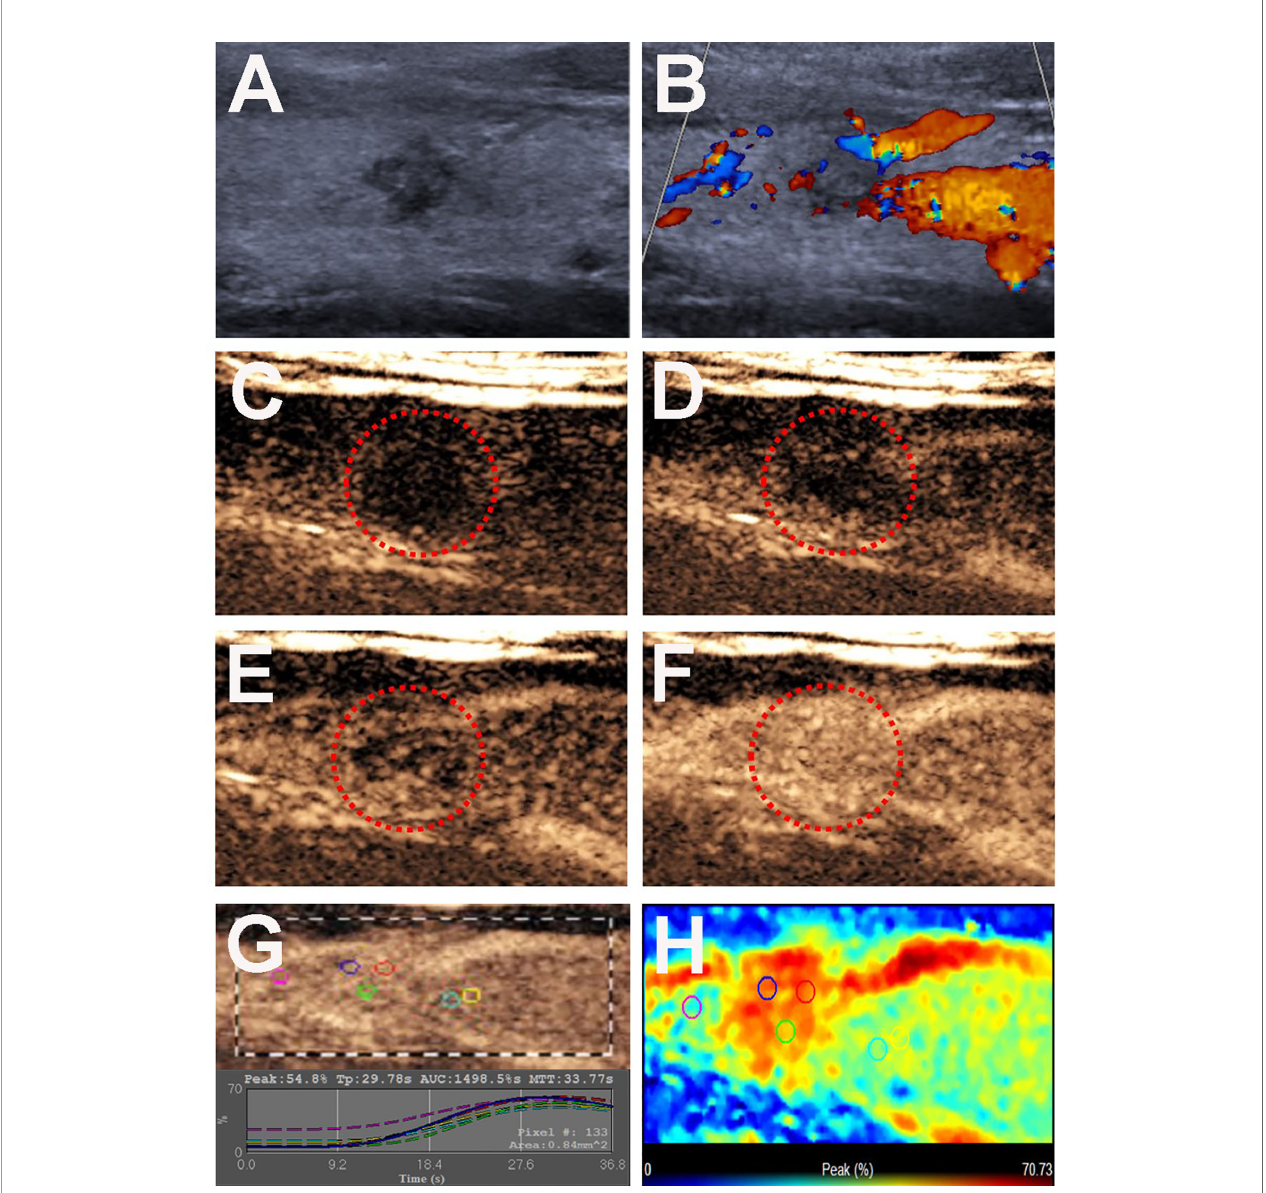
FIGURE 4 | Conventional US and CEUS images of a 26-y-old male PTC patient with Hashimoto ’ s thyroiditis of the right thyroid lobe without CLNM. (A) B-mode US image revealing a 8.0-mm solid thyroid nodule with a taller than wider shape, hypo-echogenicity, ill-de fi ned margins. (B) Doppler image revealing abundant peripheral vascularity and no obvious internal vascularity. (C – F) CEUS images revealing a centripetal homogeneous hyperenhancement of thyroid nodule from the periphery to the center, at (C) 2s, (D) 20s (wash-in), (E) 22s and (F) 34s (time to peak). (G) TICs of the thyroid nodule and peripheral thyroid parenchyma with different ROIs (different color circles). (H) Parametric color map indicating the PI values for the nodule was higher than that of adjacent thyroid